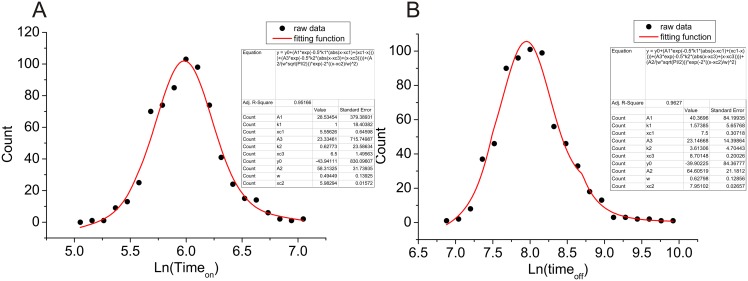
The distribution of the predicted kinetic specificity.
(A) The distribution of the logarithm of the predicted Time
on with 720 compounds binding to the Cox2; (B) The distribution of the logarithm of the predicted Time
off with 720 compounds binding to the Cox2. gaussian curve: in the center; exponential curve: near the tail. The parameter values for these distributions are presented. The analytical function consisting of a Gaussian and two exponential functions is highlighted with red line.